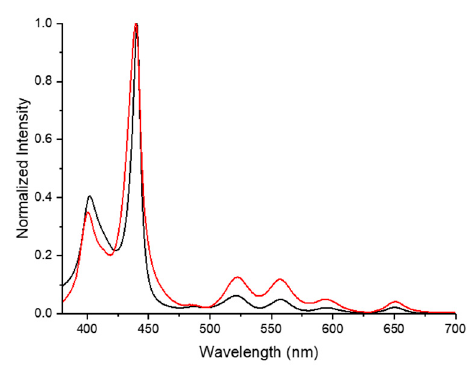
Figure 4. Normalized UV-Vis absorption spectra of the StarP in aqueous solution (black line) and thin film deposited on PHMS surface (red line).